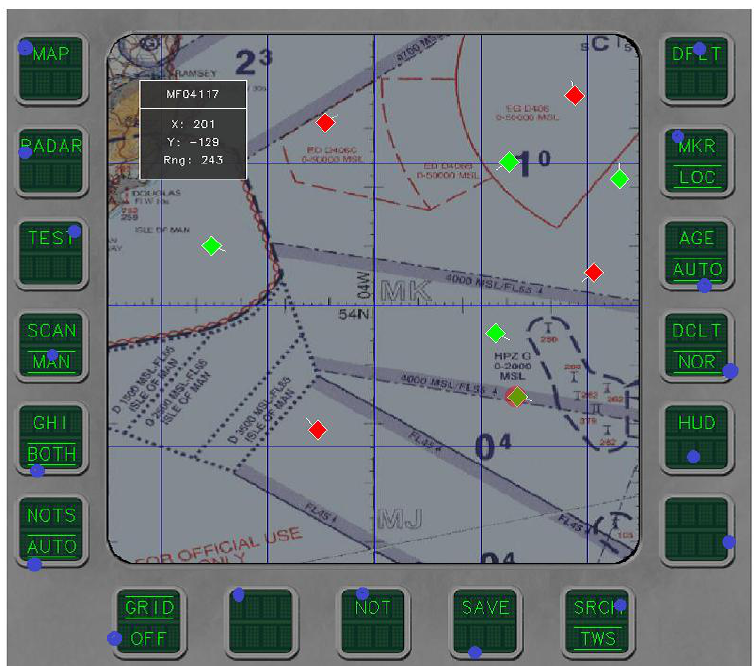
Figure 12. Hotspots for a representative MultiFunction Display.